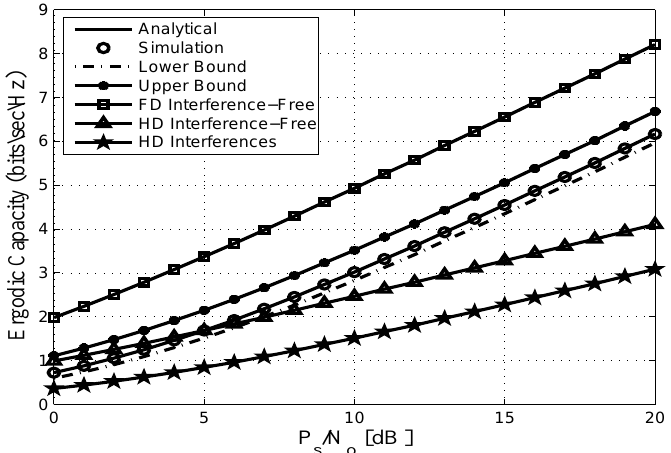
Figure 5. Ergodic capacity vs. P S / N o for different relaying techniques with γ RR = γ ID = 5 dB, m ij = 2, d SR = 0.45, d RD = 0.55, and η = 3.18.